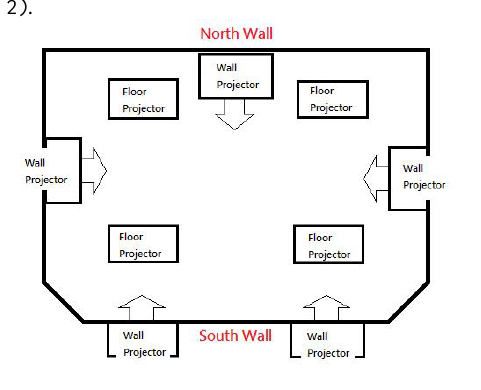
Figure 1. Floor plan of Kunyu Quantu World Map installation.